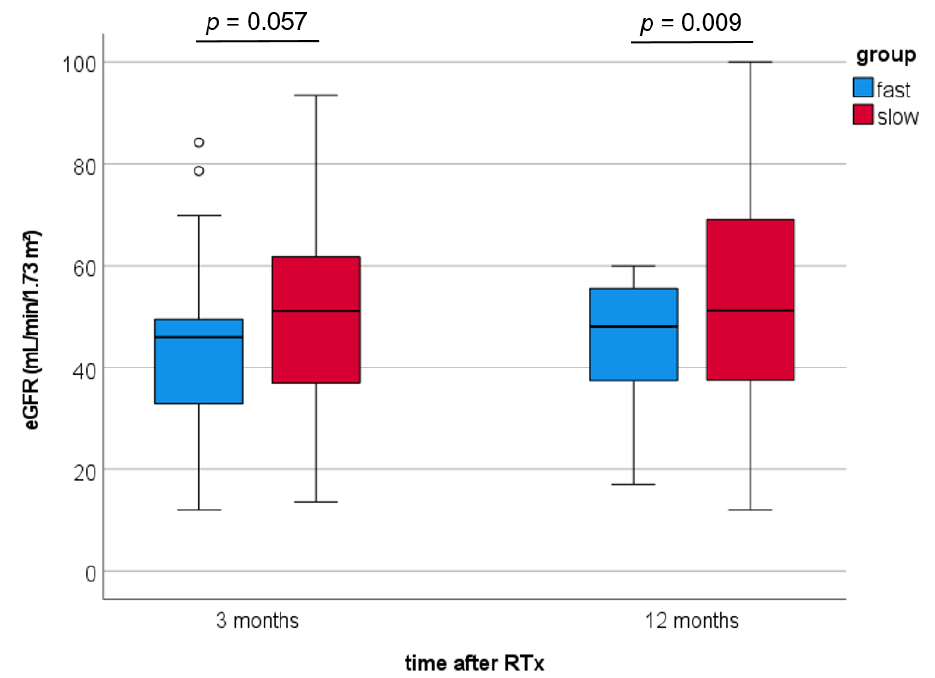
Figure 3. Renal function of fast and slow tacrolimus metabolizers three and twelve months after transplantation. eGFR, estimated glomerular filtration rate; RTx, renal transplantation.